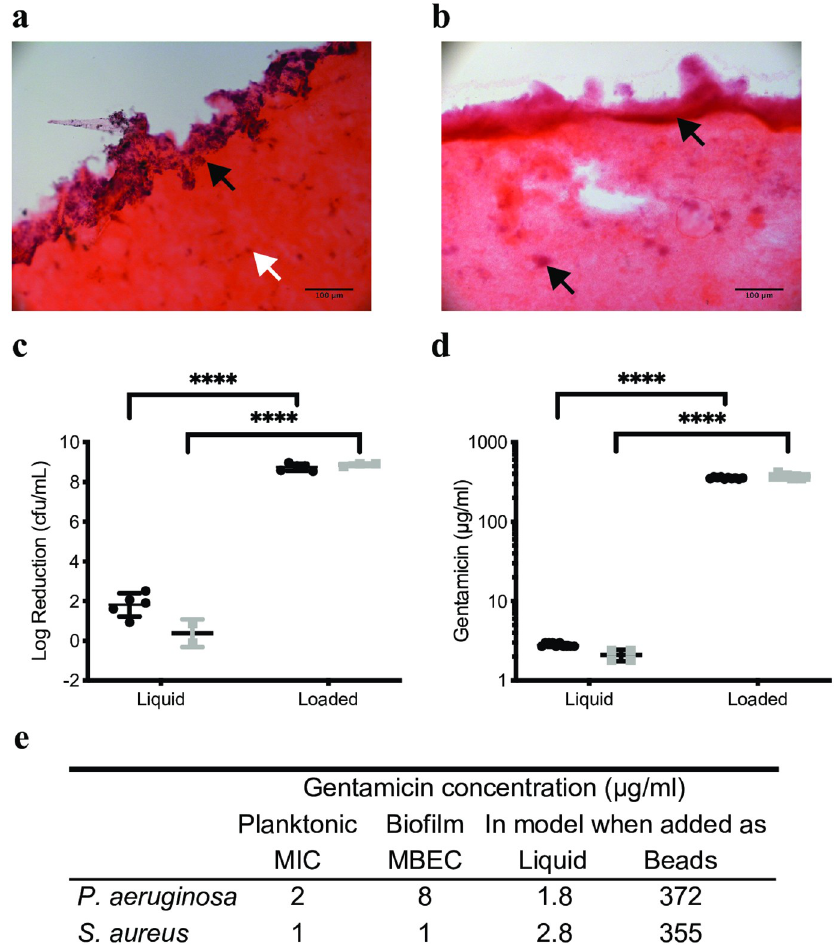
Fig 2. Gentamicin added in CSB eradicated biofilms of S . aureus and P . aeruginosa because the amount of gentamicin detected in the bulk of the model exceeded the MIC by two orders of magnitude. The IVM model was sectioned and stained with H&E, biofilm appears purple and the collagen is stained pink. The S . aureus biofilm (a) localised mostly on the surface of the model (black arrow), dead fibroblasts can be seen in the bulk of the model (white arrow). The P . aeruginosa biofilm (b) penetrated into the bulk of the model and formed microcolonies (black arrows). (c) Log reductions in S . aureus (black circles) or P . aeruginosa (grey squares) were 0–2 when gentamicin at the C max concentration was added to IVM models but exceeded 8 logs when gentamicin loaded CSB were added to the models representing eradication of the biofilm. These log reductions corresponded to concentrations of gentamicin of around 2 μ g/ml in the models when liquid gentamicin was added to the models or 350 μ g/ml when gentamicin was added in CSB (d). The concentration of gentamicin in the models when added at the C max concentration was around the MIC for S . aureus and P . aeruginosa (e), however when added in CSB the concentration of gentamicin in the models was two orders of magnitude higher. ���� indicates P <